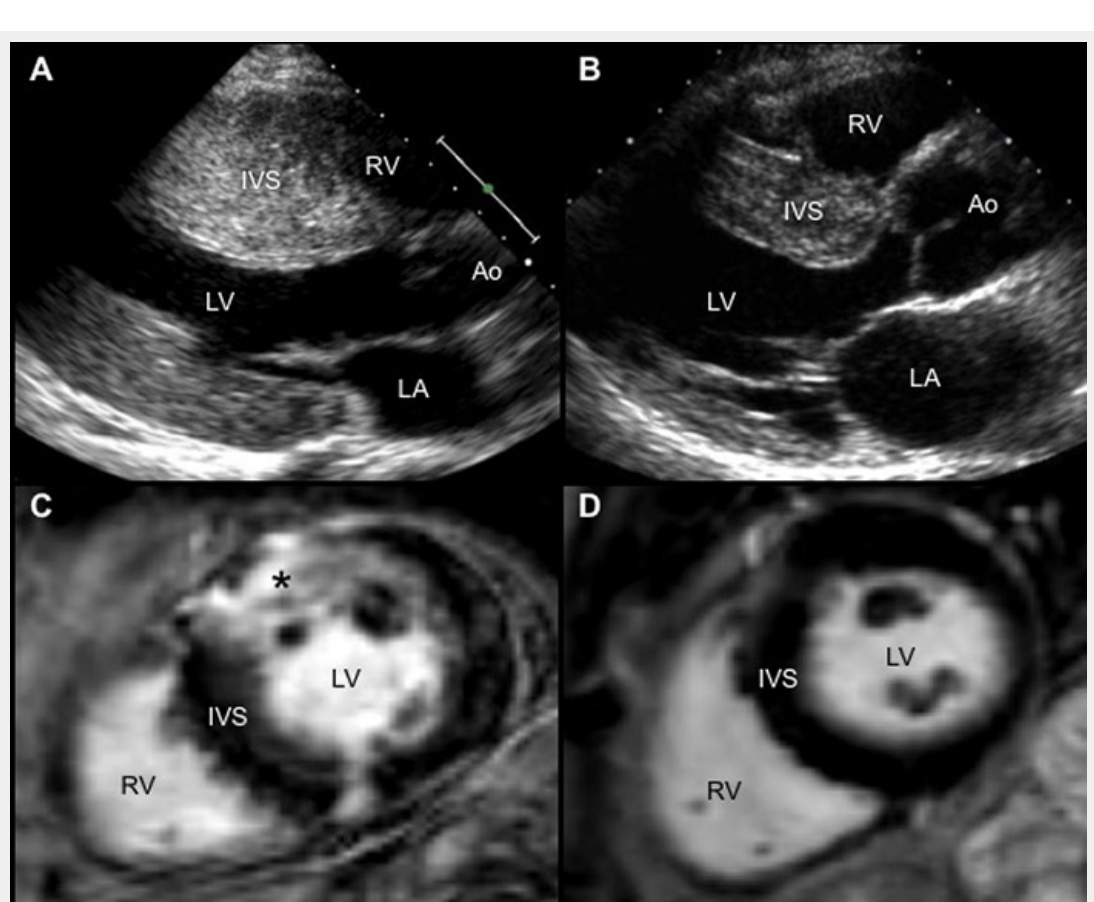
Figure 1 (A) Patient in NYHA functional class II with nonobstructive HCM and a maximal wall thickness of 35 mm and elevated hs-cTnT level (0.05 ng/ ml). (B) Patient with obstructive HCM controlled with beta blocker therapy, a maximal wall thickness of 19 mm and normal hs-cTnT level. (C) Patient with nonobstructive HCM and a maximal wall thickness of 22 mm. On CMR, patient shows extensive LGE (17% of LV mass) in the anterior wall segments (*) along with an elevated hs-cTnT level (0.031 ng/ml). (D) Patient with nonobstructive HCM and a maximal wall thickness of 16 mm without LGE on CMR and normal hs-cTnT level. Ao = Aorta; CMR = cardiovascular magnetic resonance; HCM = hypertrophic cardiomyopathy; hs-cTnT = high-sensitive cardiac troponin T; IVS = interventricular septum; LA = left atrium; LGE = late gadolinium enhancement; LV = left ventricle; NYHA = New York Heart Association; RV = right